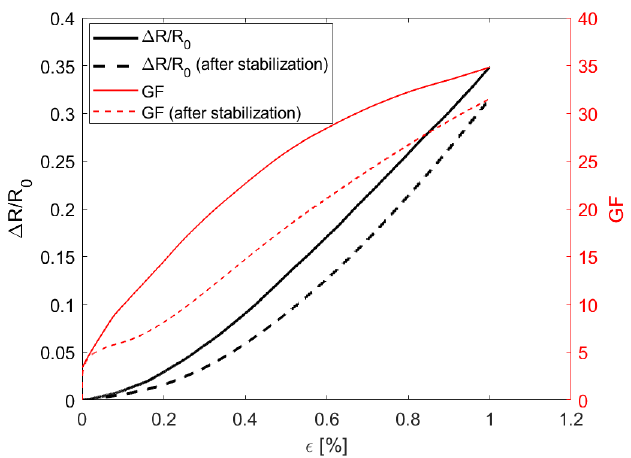
Figure 12. Variation in the electrical resistance (black lines) and GF (red lines) as a function of ε.